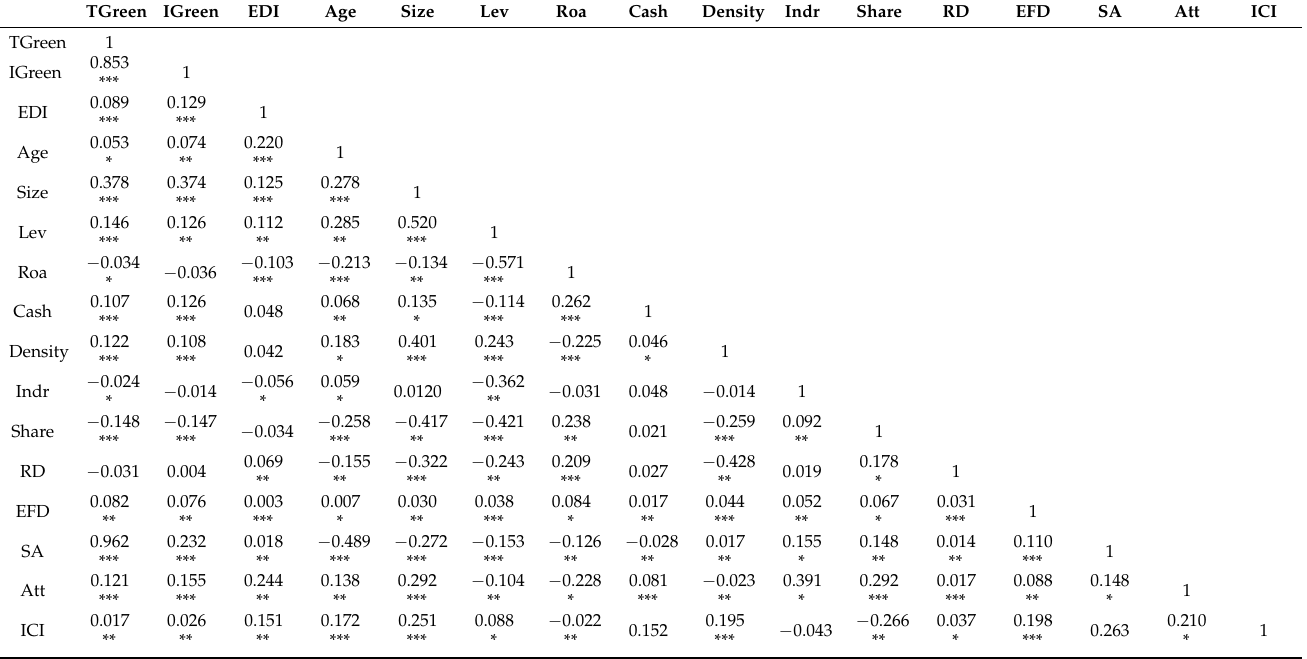
Table 3. Correlation test of